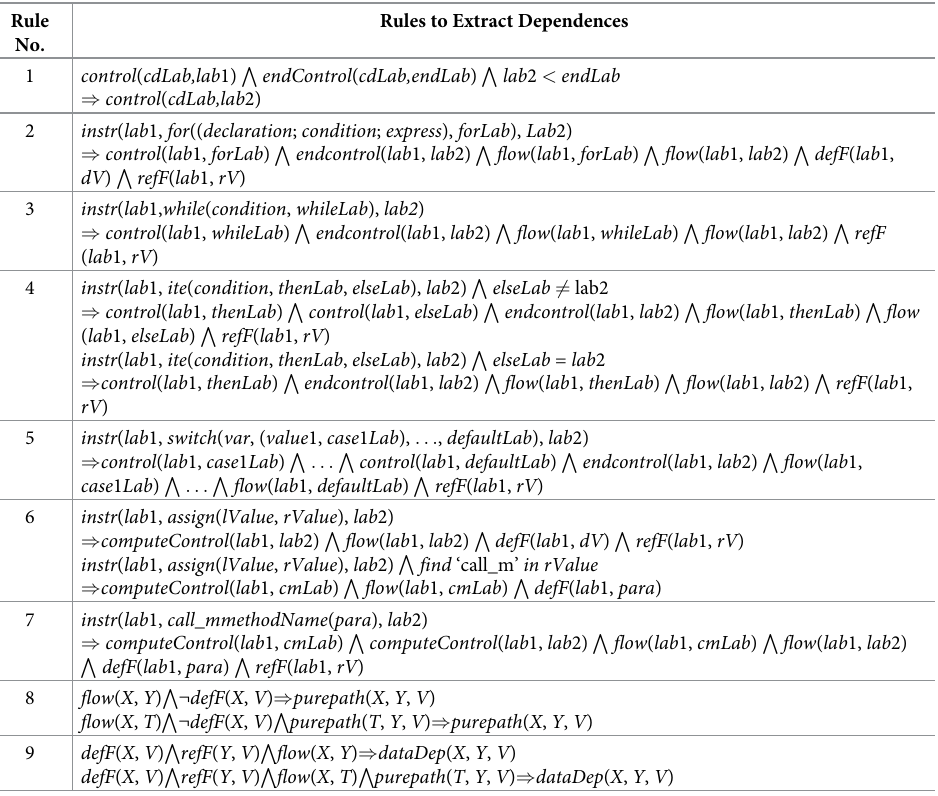
Table 2. Rules to extract control and data dependences from facts. Rule